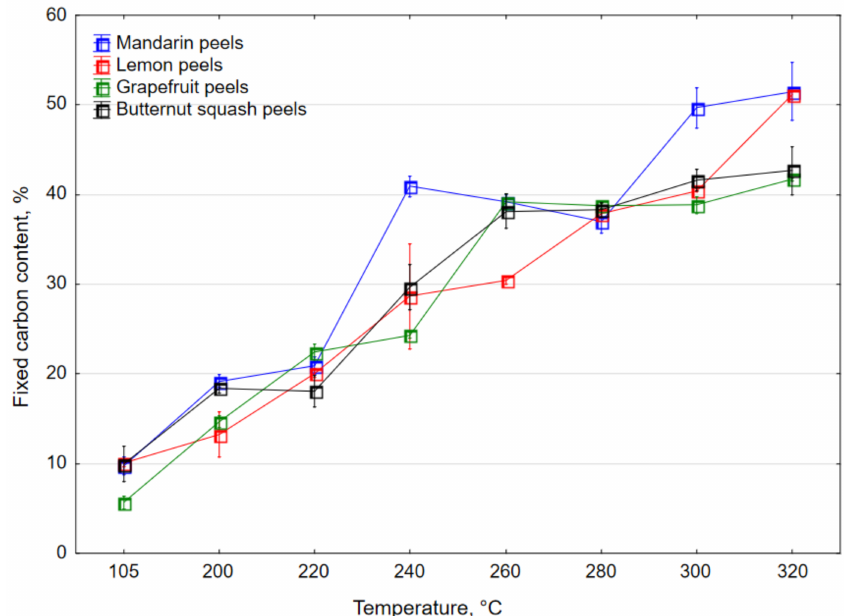
Figure 4. Fixed carbon content in the torrefied waste biomass.